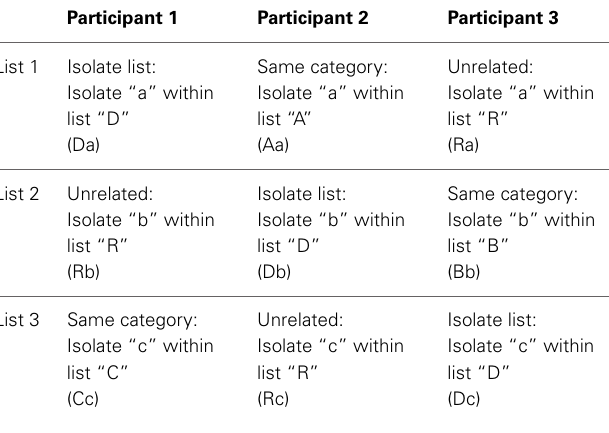
Table 1 | Building three lists: “Von Restorff,” “same category,” and “unrelated” from four categories, “A,” “B,” “C,” and “D,” by presenting the same isolate to three different participants, within three types of